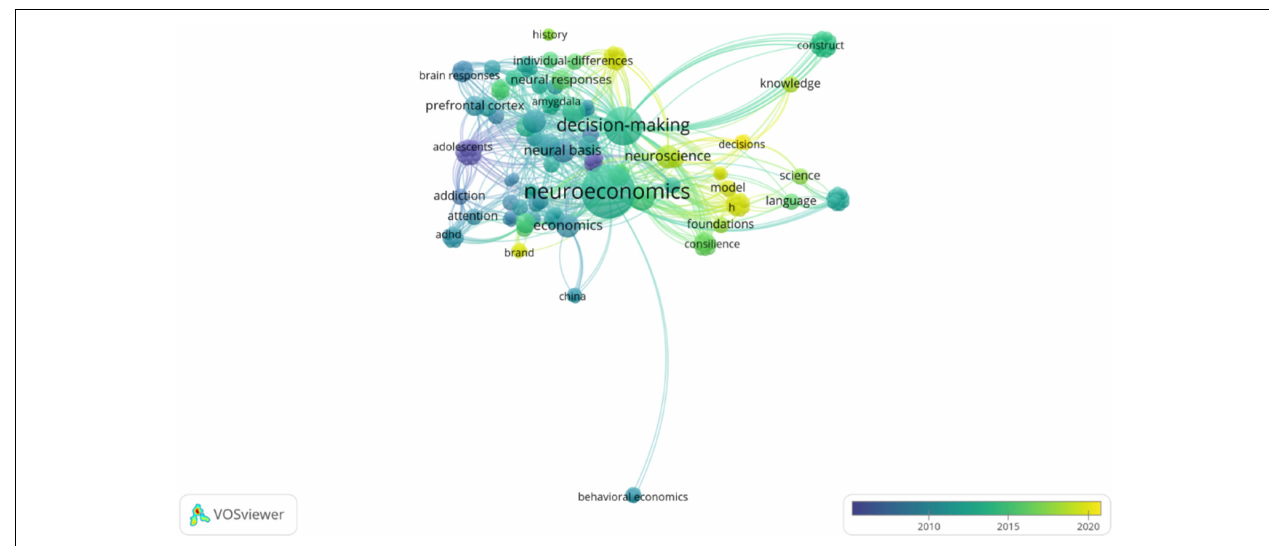
FIGURE 1 | Scientometrics analysis of “Neuroeconomics and culture” for 2003–2022. Source: VOSviewer interpretation from web of science